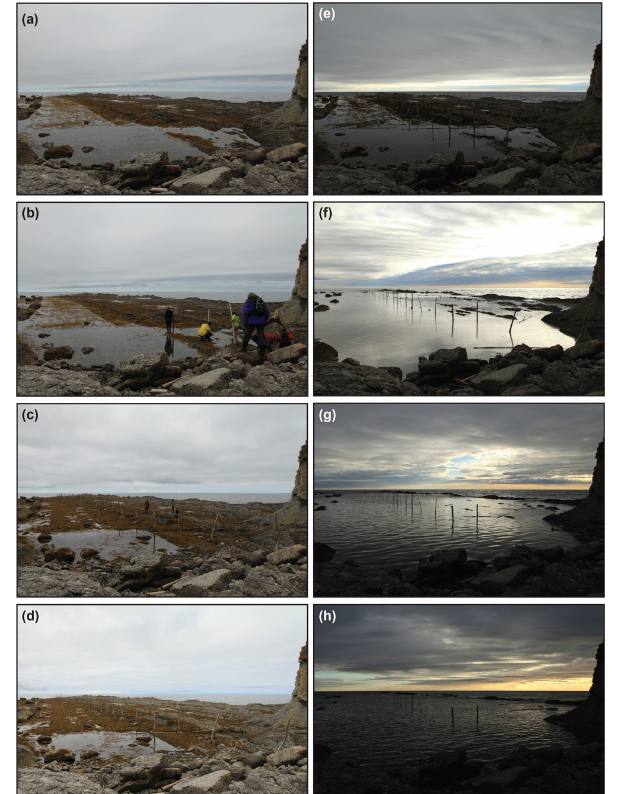
Figure 4. Samples from time-lapse sequence of photographs taken at 10s intervals during the construction and dissolution of the in- stallation. (a) Site immediately before installation began. (b) Start of installation on falling tide. (c) Towards the end of the installa- tion. (d) Completed installation near low tide. (e–h) Afternoon and evening dissolution of the sculpture during rising tide.